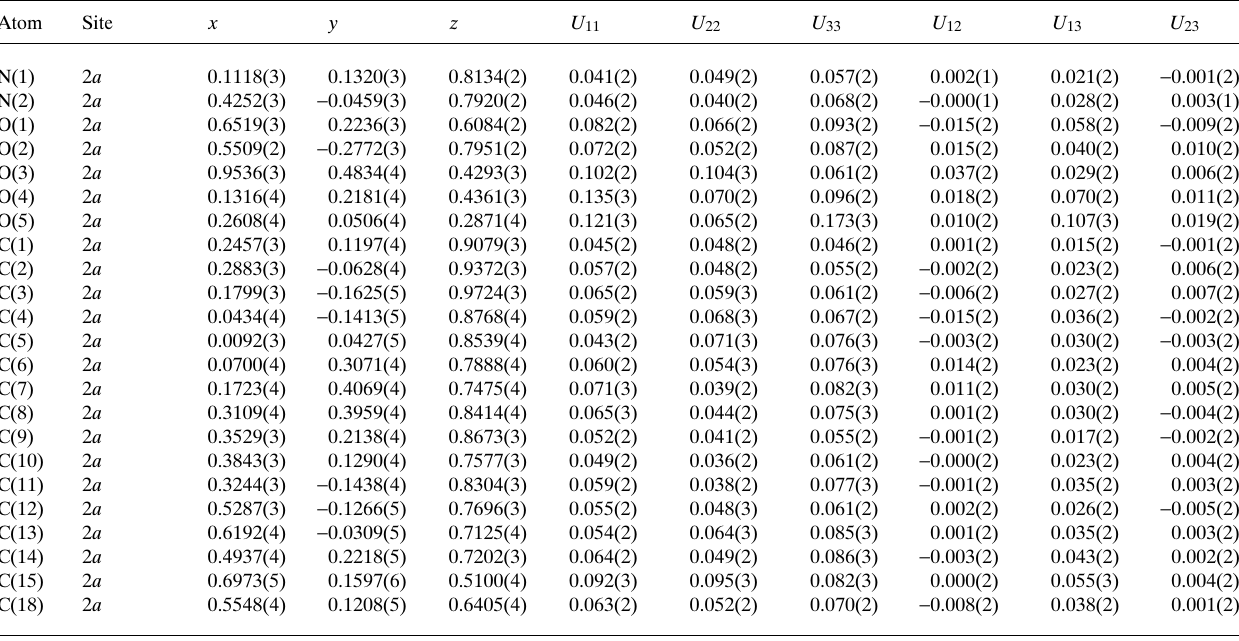
Table 3. Atomic coordinates and displacement parameters (in Å 2 ) .